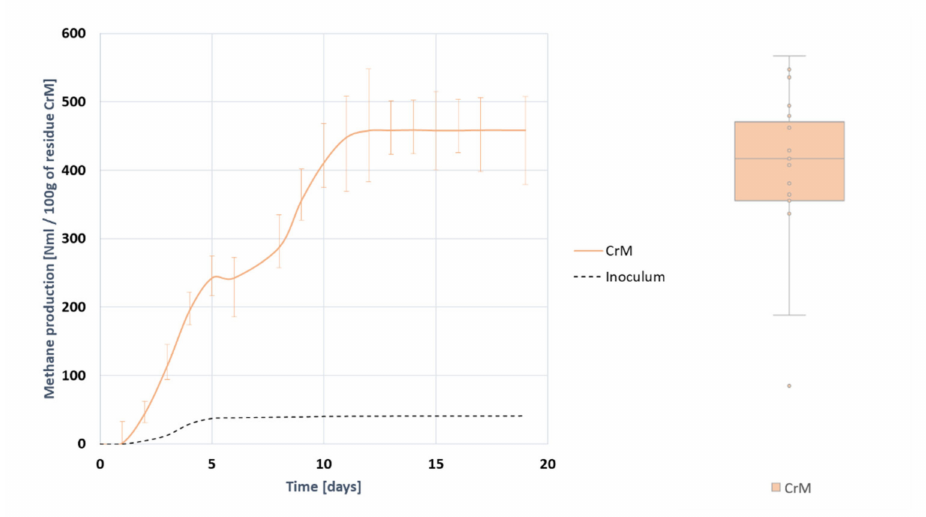
Figure 2. Gross methane production mean curve from the anaerobic digestion of 100 g of residue CrM and box diagram of its